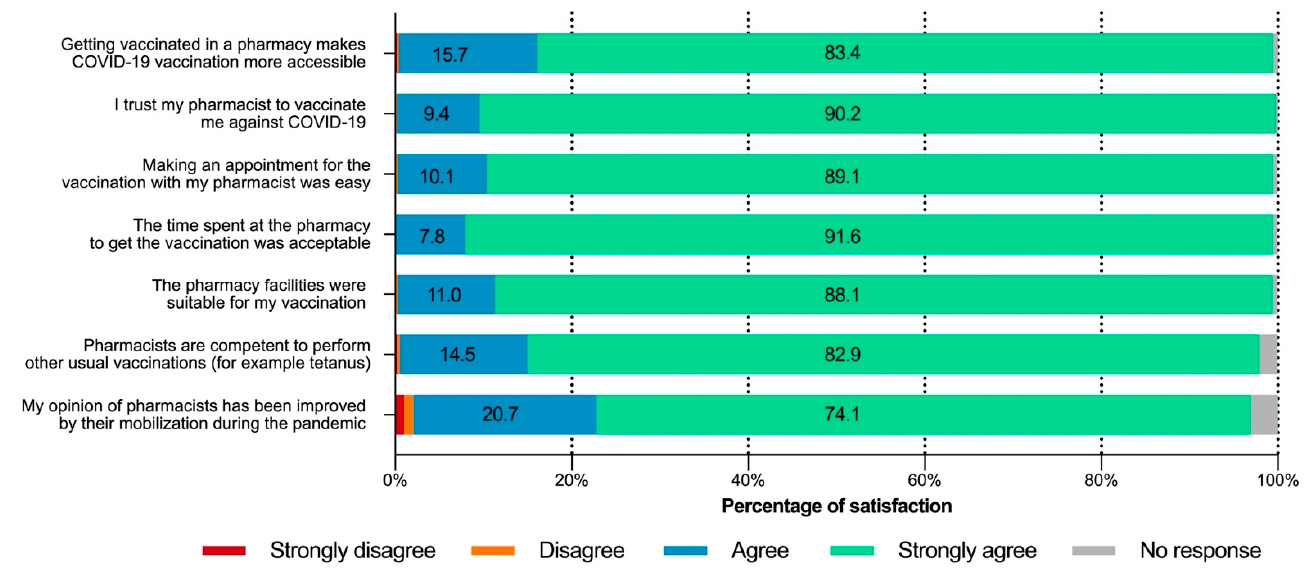
Figure 2. Respondent opinions from the “PharmaCoVax” survey ( n =